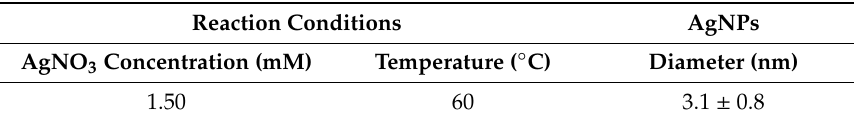
Table 1. Reaction conditions for the synthesis of GO–AgNPs and average size of AgNPs formed.